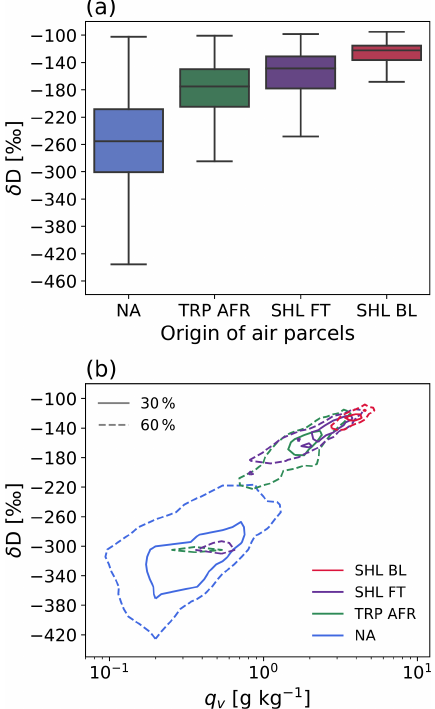
Figure 8. Isotopic signature of COSMO iso air parcels arriving at 500–700hPa above Tenerife and originating from the upper-level extratropical North Atlantic (NA, 26% occurrence frequency), from tropical Africa (TRP AFR, 16%), from the upper levels above the Saharan heat low (SHL FT, 26%), and from the convective bound- ary layer of the Saharan heat low (SHL BL, 32%). (a) Boxplots of the δ D signal separated by air parcel origin. The boxplots show the interquartile range by the extent of the box and the median by the black line in the box. The whiskers correspond to 1.5 times the pro- portion of the interquartile range past the lower and upper quartiles. (b) Relation between δ D in water vapour and q v . Solid and dashed contours show the 30% and 60% frequency isolines of normalised two-dimensional histograms of respective transport